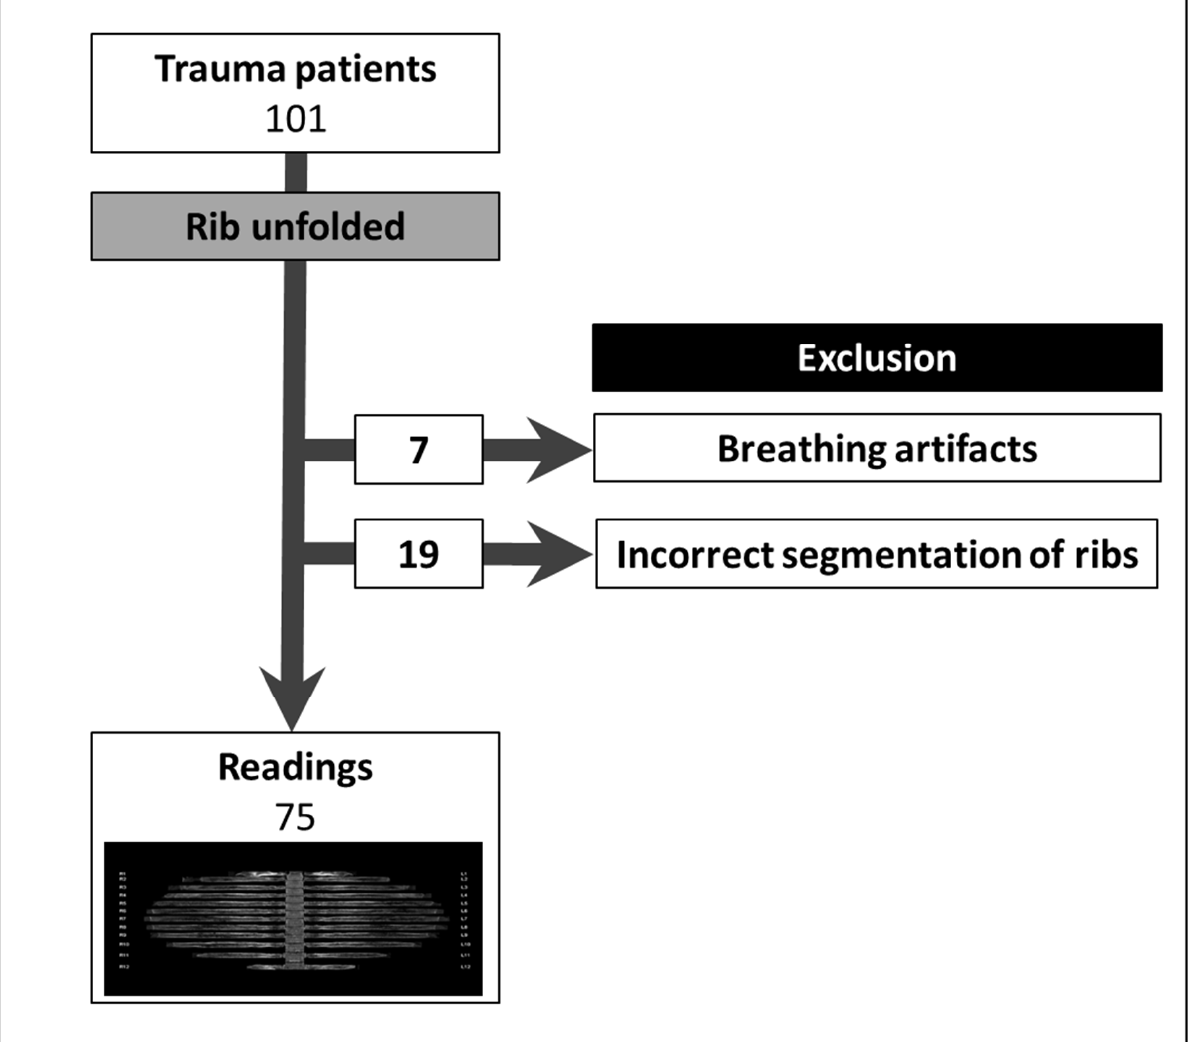
Figure 6. Twenty-six of the 101 patients were excluded. Seven owing to breathing artifacts and 19 owing to the faulty imaging of one or more ribs in the unfolded view.